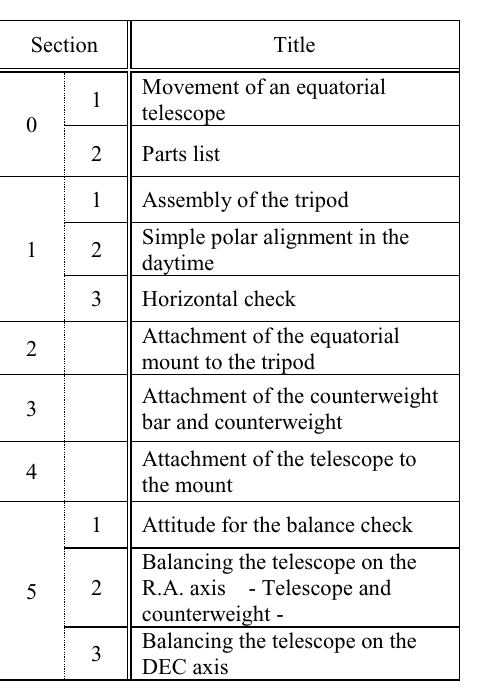
Table 2. The list of the video